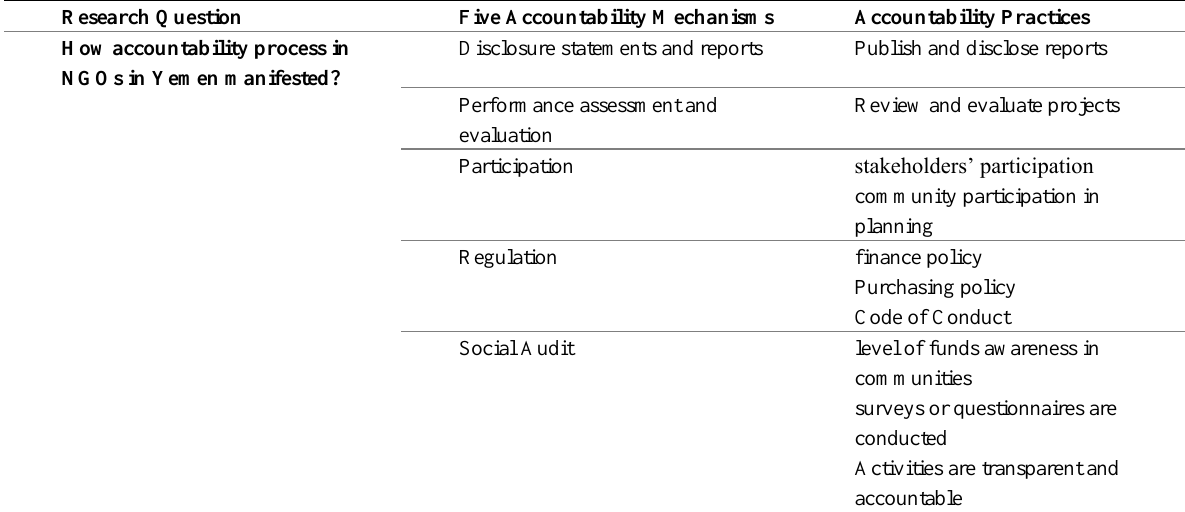
Table 1: Level of Accountability Practices